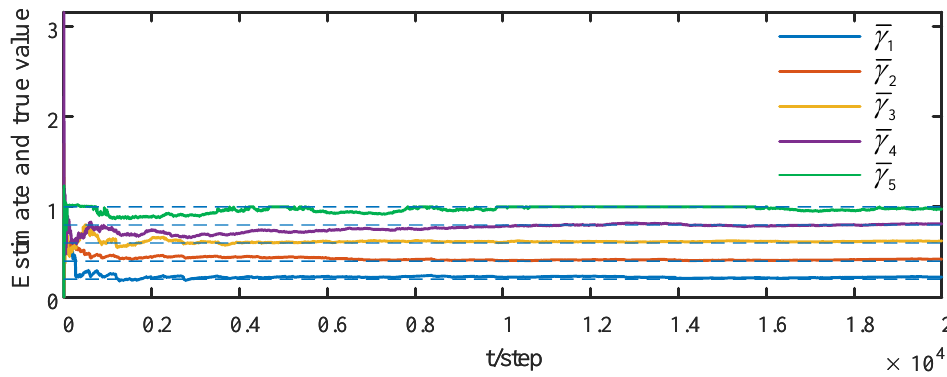
Figure 5. Identified results of unknown attack rates of deception attack signals (authors’ own processing).